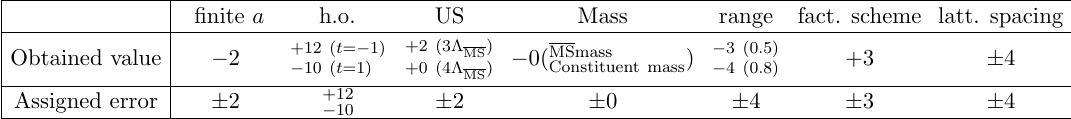
Table 7 . Estimates of systematic errors in Analysis (II) from variations of the central value of (cid:11) s ( M 2 ) in units of 10 (cid:0) 4 when varying the analysis conditions. In the upper row, variations are Z shown. (Detailed conditions are shown inside brackets). Mass e(cid:11)ects are negligibly small in both cases. Assigned systematic errors are shown in the lower